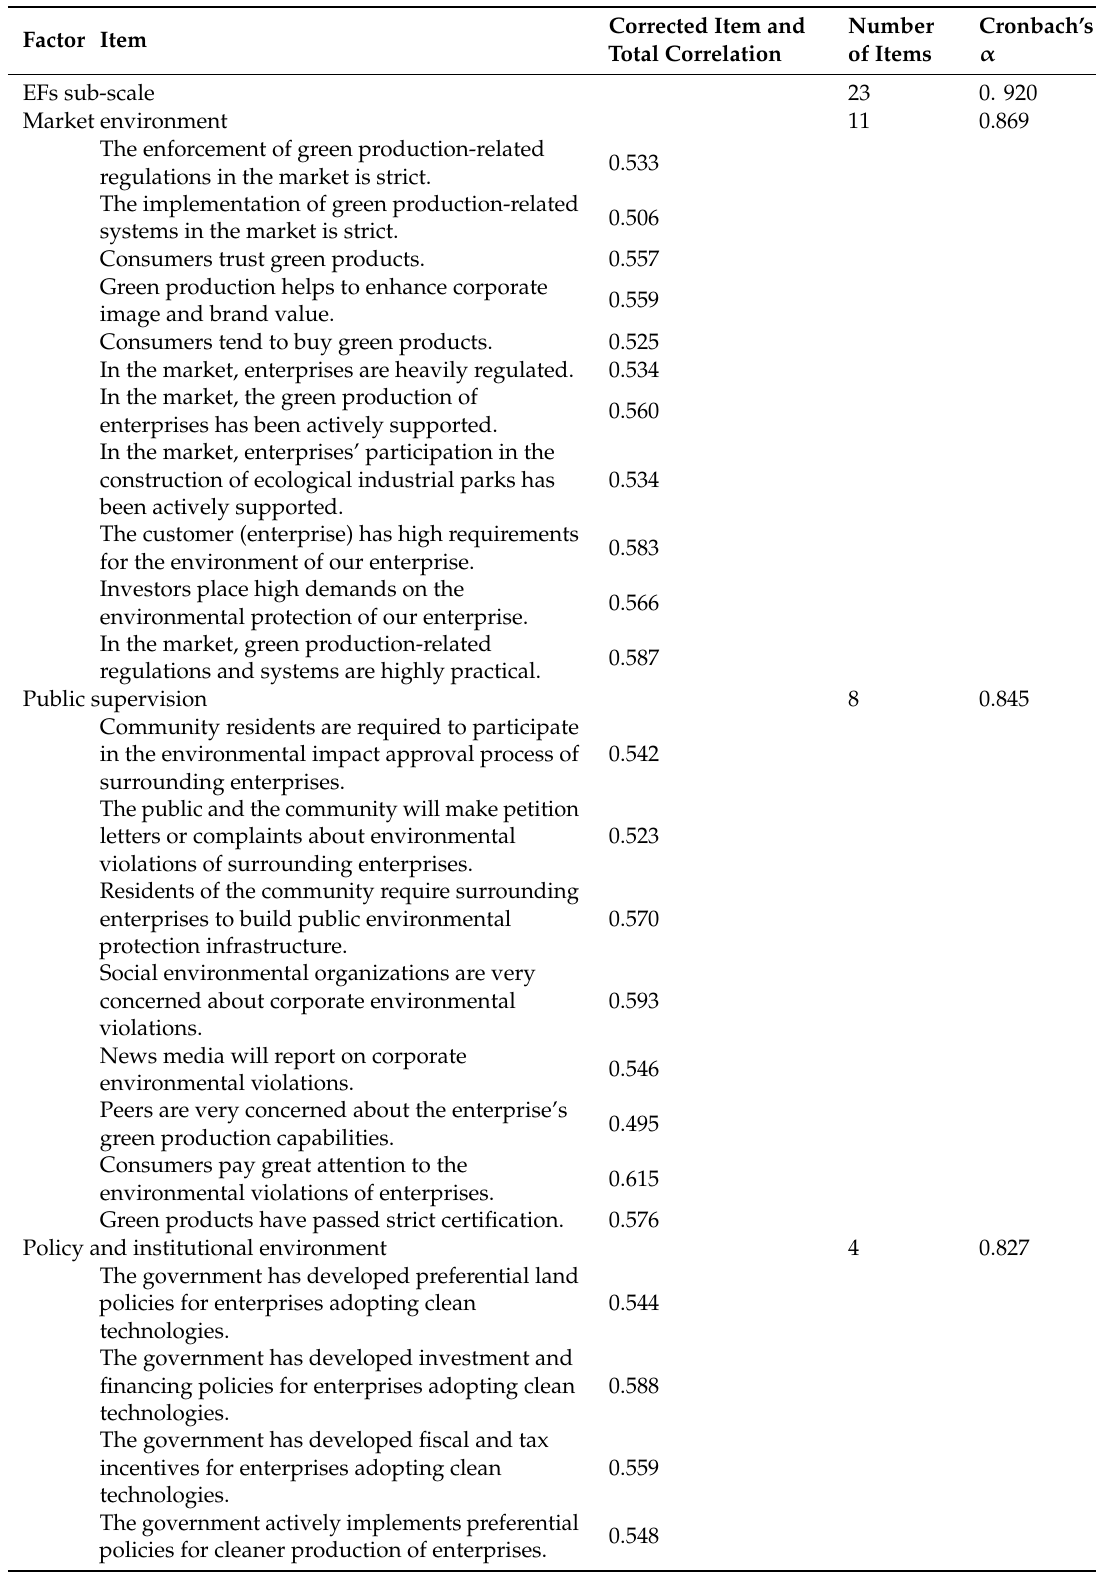
Table 7. Test results of the EFs sub-scale ( N =